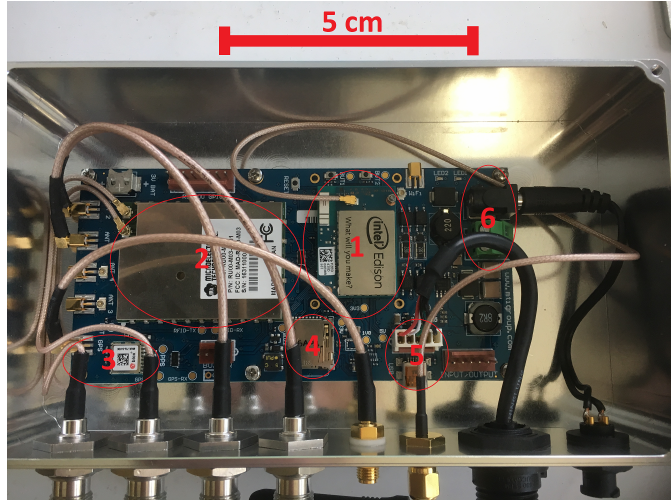
Figure 1. Printed Circuit Board showing the main components: (1) IoT module; (2) HP-SiP module; (3) GNSS receiver; (4) micro-SD card; (5) micro-USB I/O; and (6) power